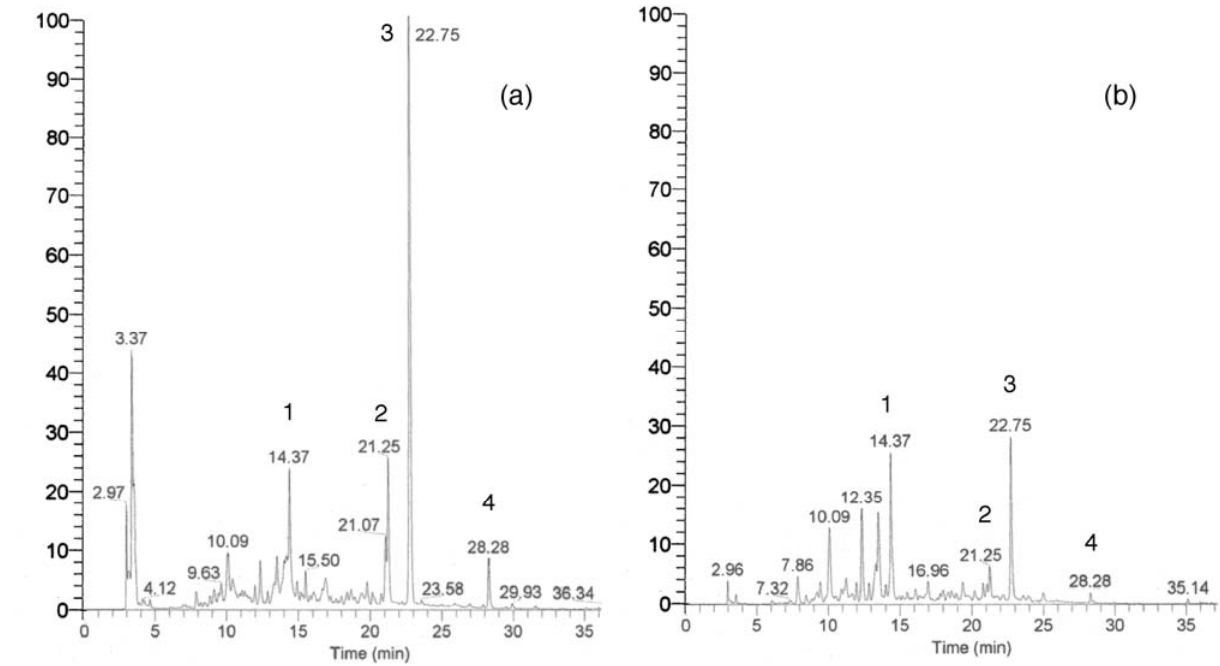
Figure 9. Simultaneously recorded DAD chromatograms of a red orange juice at two different wavelengths, for examples, at (a): 280 nm and (b): 325